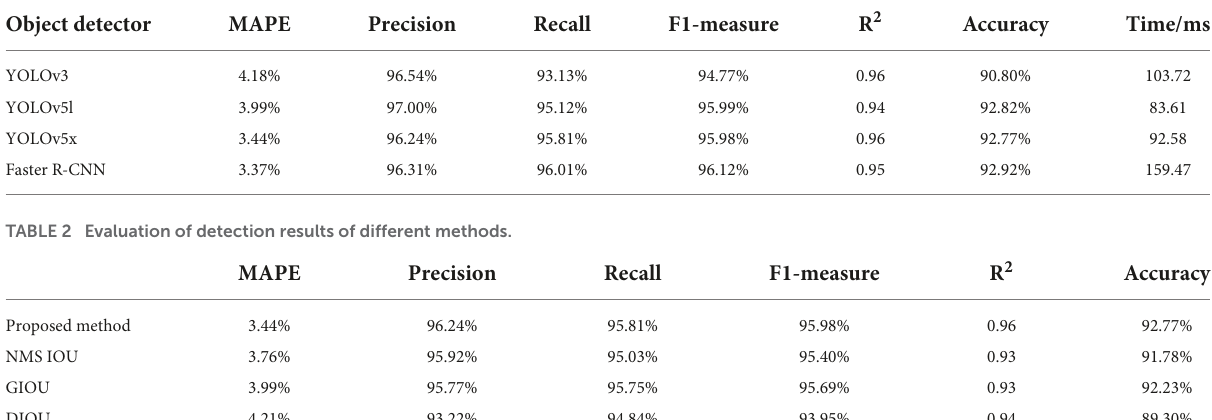
TABLE 1 Comparison of different object detectors for panicle counting.